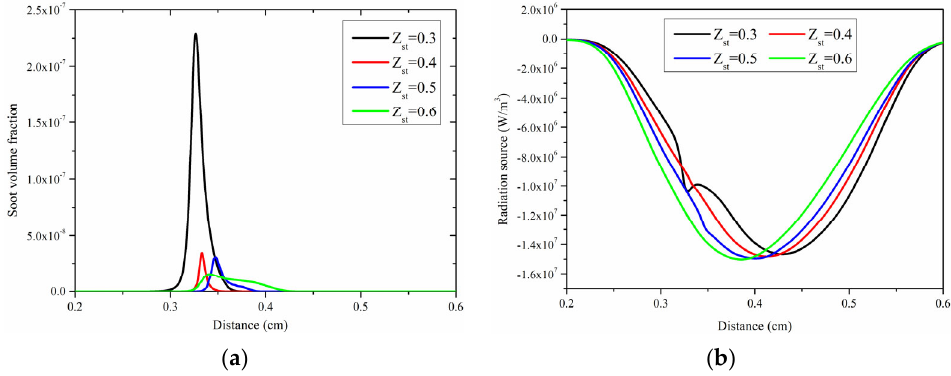
Figure 7. The distributions of SVF ( a ) and radiation source ( b ) in cases 2.1–2.4.